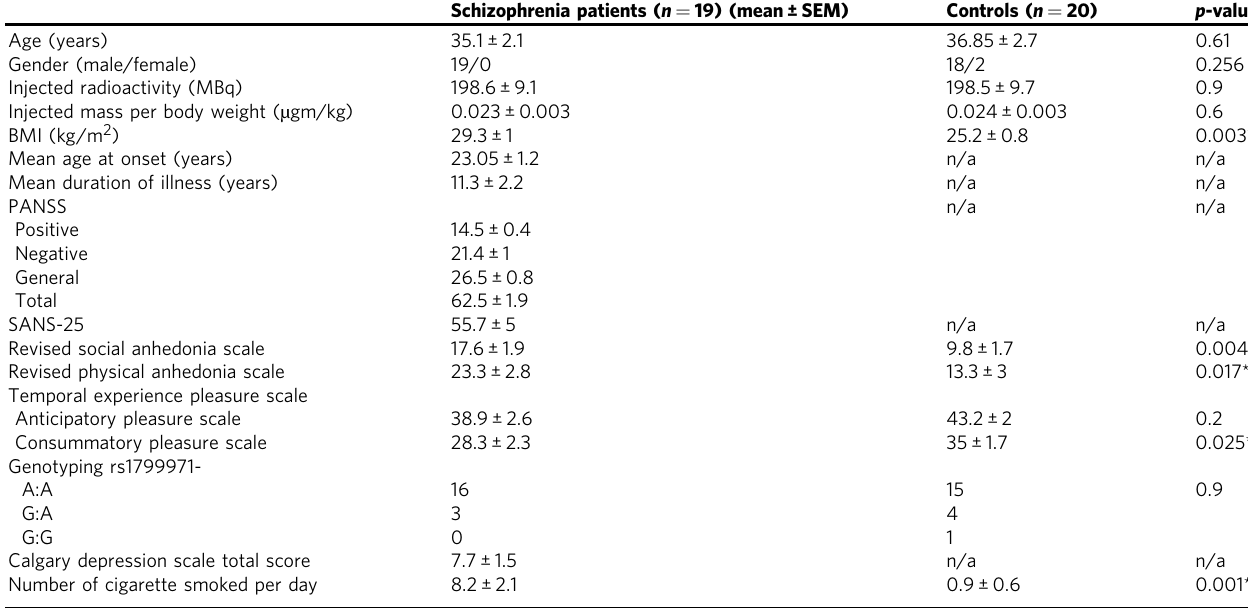
Schizophrenia patients ( n = 19) (mean ± SEM)